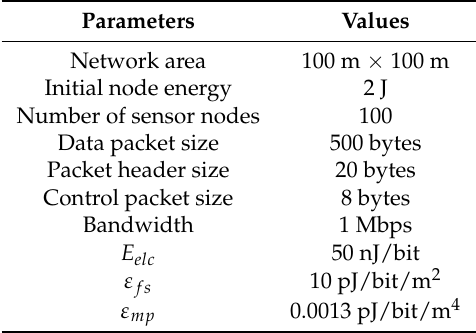
Table 1. Simulation parameters and their